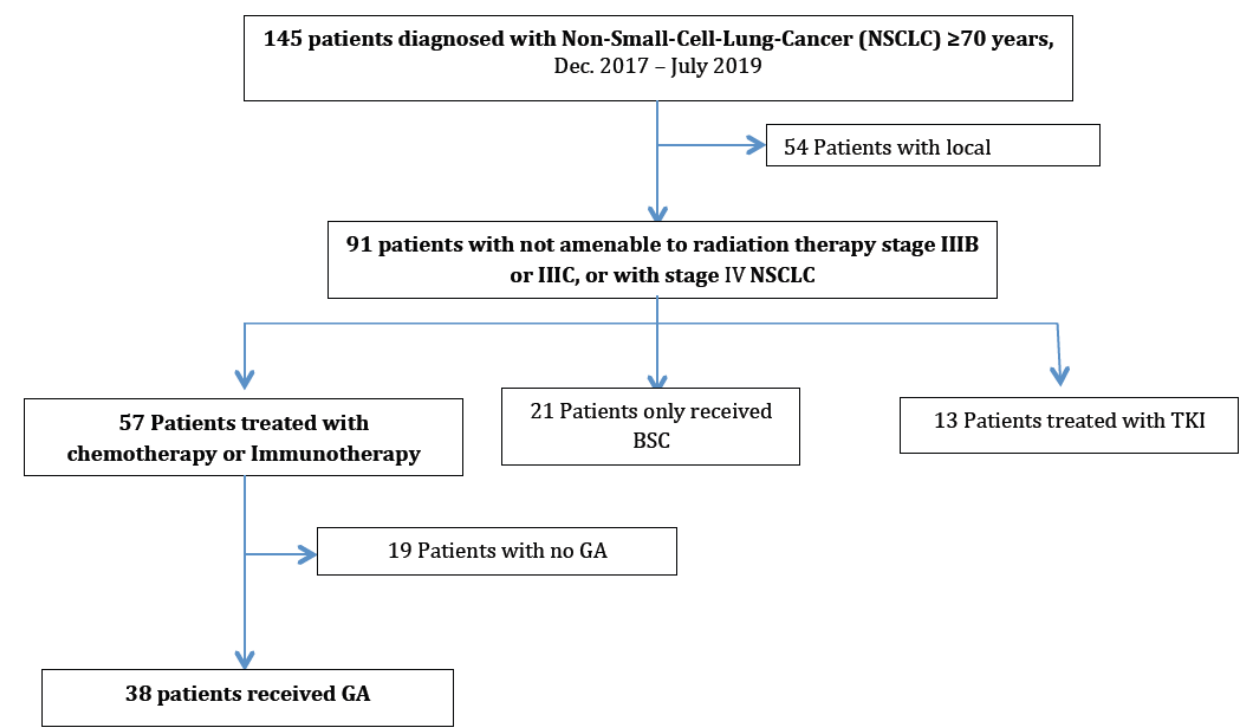
Figure 1. Figure 1. Flow-chart. GA: geriatric assessment; TKI: tyrosine kinase inhibitor; BSC: best supportive care.